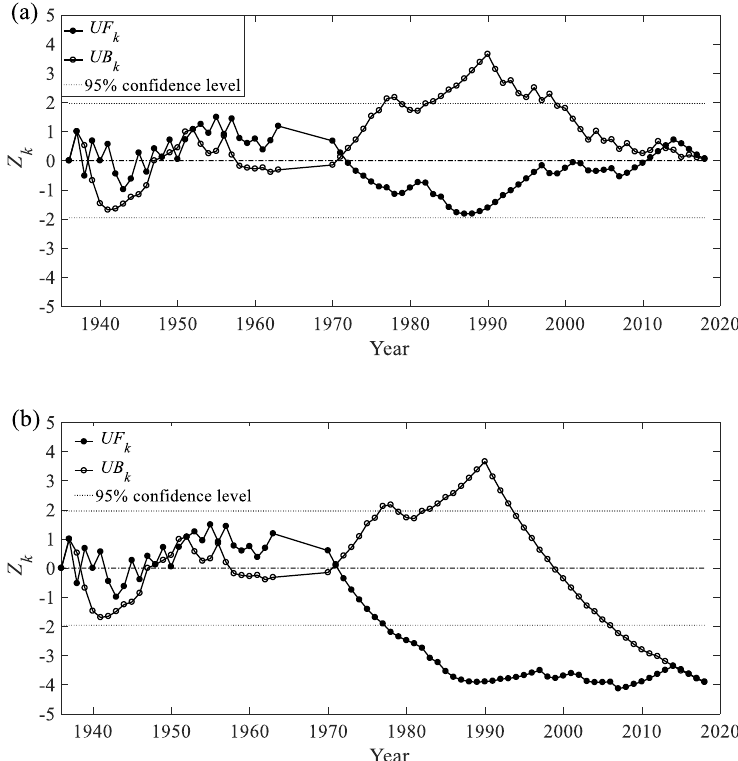
Figure 4. Mann–Kendall (MK) trend test analysis of annual: ( a ) River discharge and ( b ) sediment load of the Volta River.